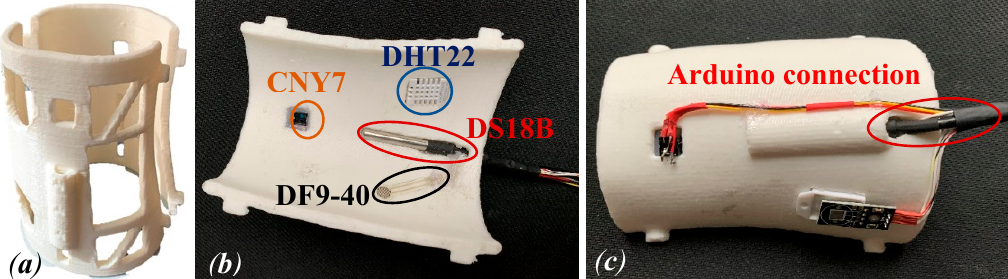
Figure 8. The real model of the arm splint obtained from the 3D printer ( a ). Splint assembled with the different sensors ( b ) and wires for the connection to the Arduino board ( c ).